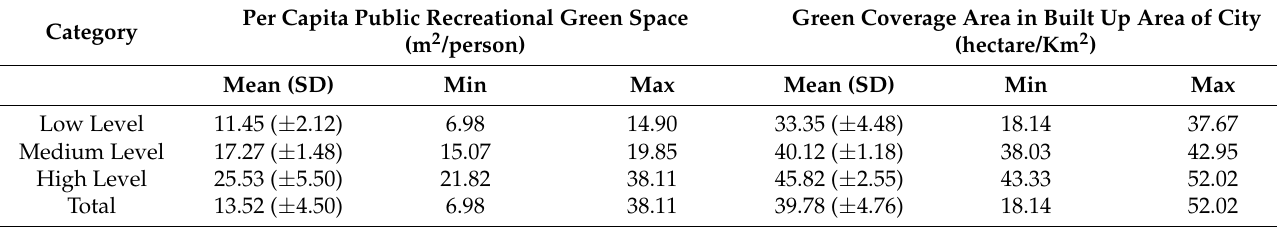
Table 1. Descriptive statistics of urban green space